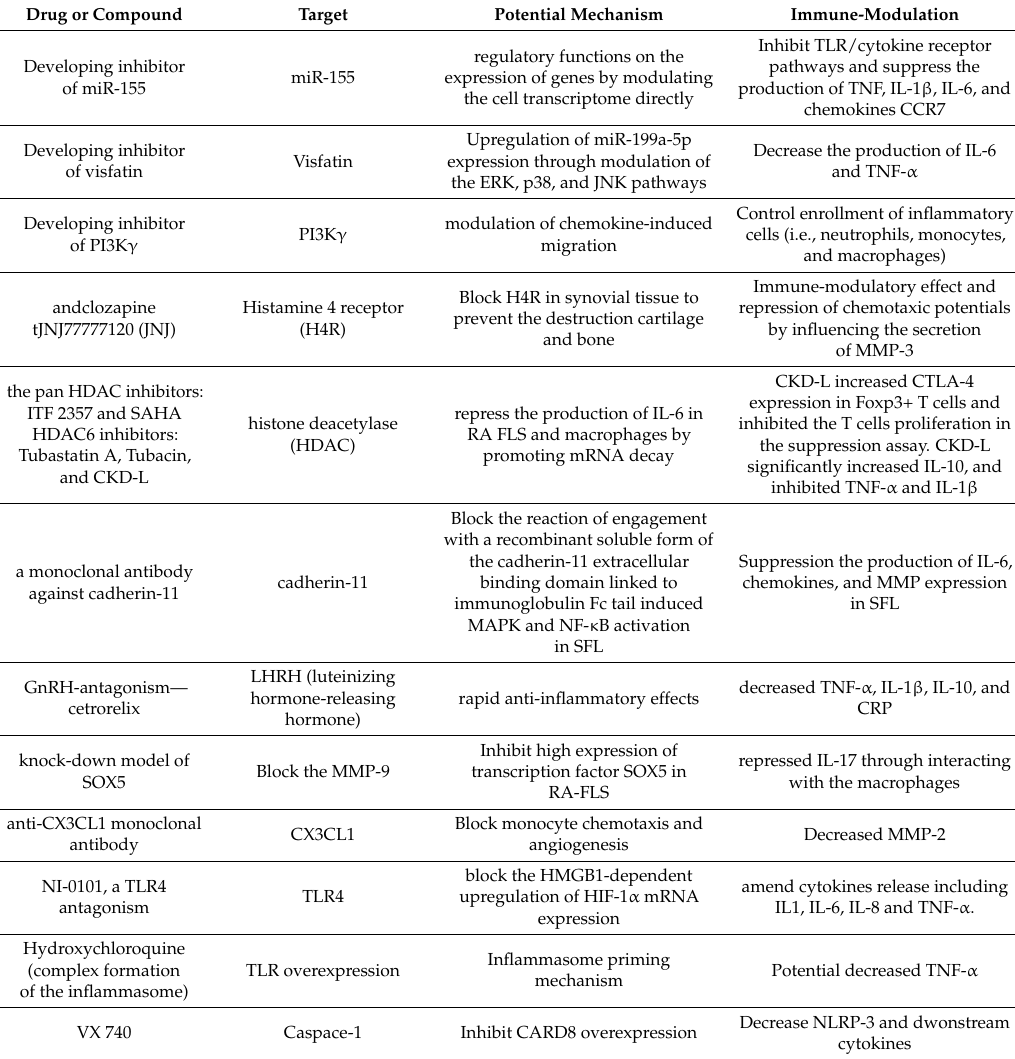
Table 2. Summary of potential targets for